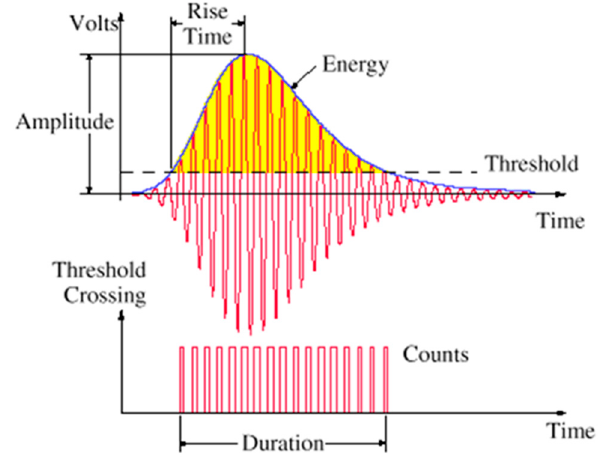
Figure 2. The definitions for acoustic emission parameters Figure 2 . The definitions for acoustic emission parameters [26].